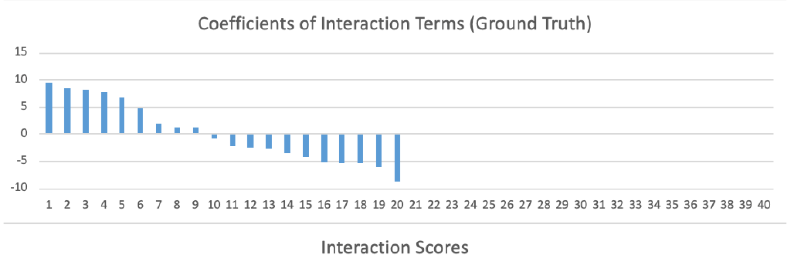
Table 4. The interaction scores, PDV interaction values and GSM interaction coefficients applied to 306 the true relationship underlying Simulation Data #2 for all six variable pairs. 307